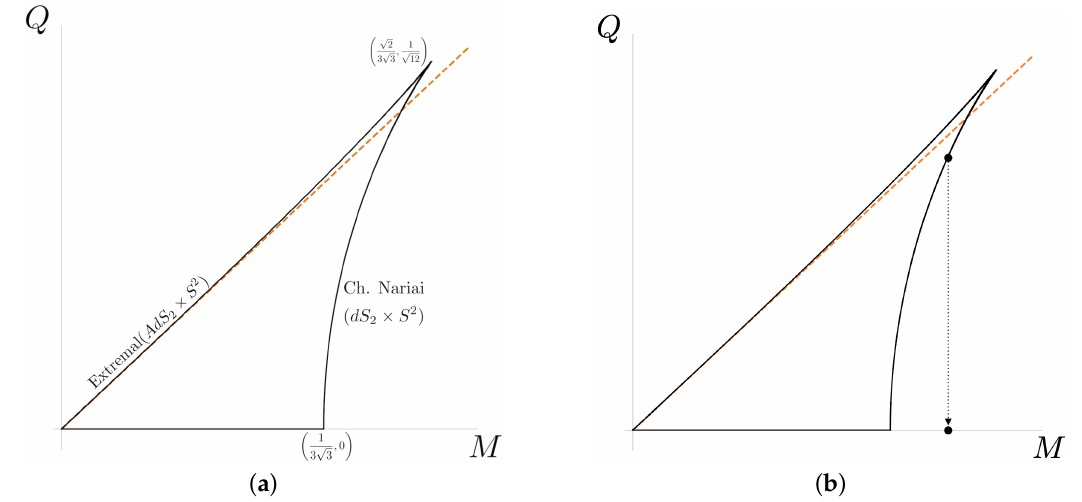
Figure 4. Figures taken from [66]. ( a ) Phase space of Reissner–Nordström–de Sitter black holes. ( b ) Decay of Nariai black holes by emission of particles with m 2 (cid:28) qE , so that they discharge almost instantaneously without effectively loosing